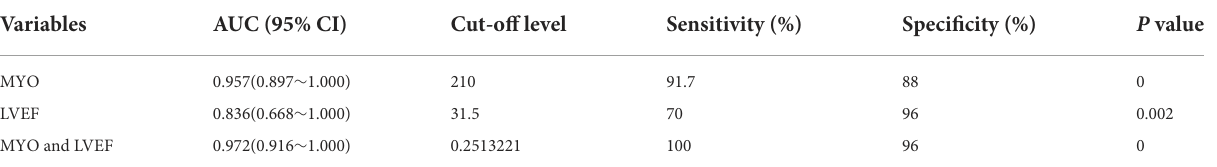
TABLE 5 ROC analysis of MYO, LVEF, and combination in the diagnosis of FM in-hospital death.